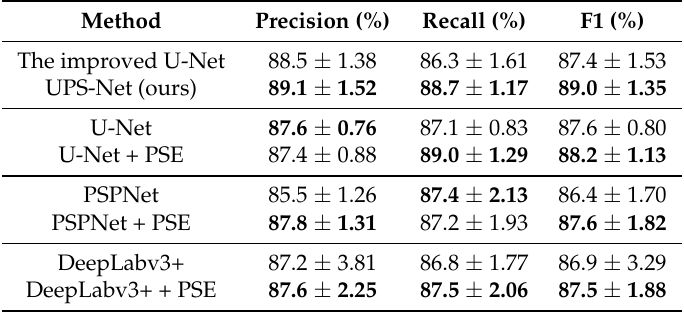
Figure 11. Visualization: the weight information of vector E from the squeeze-excitation module. The horizontal axis shows channels of the vector E . The vertical axis shows weights of the vector E . Table 4. Comparison of different FCN-based networks with and without the PSE structure (average of 5 runs with the standard deviation). The values in bold format are the highest